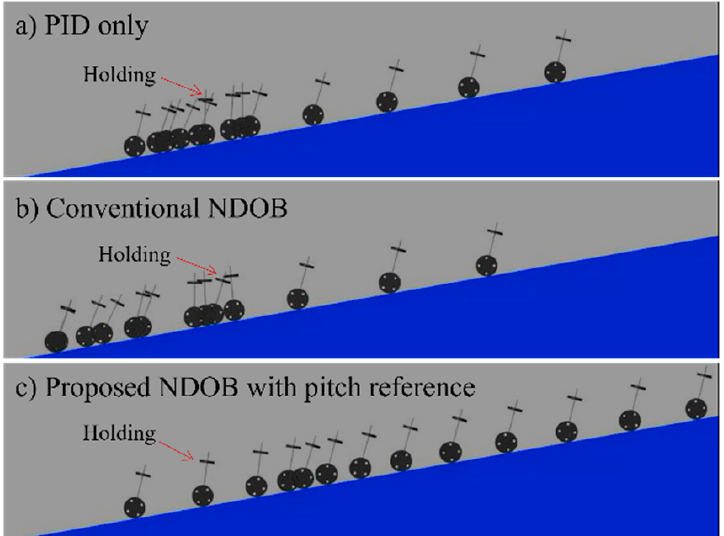
12 of 19 Figure 8. Climbing a ramp with an unknown slope of 10 degrees. The pitch references for PID and conventional NDOB were zero. Secondly, as shown in Figures 9 and 10, as the TWIP robot steadily climbed the ramp, the velocity reference changed from 1.5 m/s to 0 m/s at 10 s to hold a stationary state for 3 s. (1) When applying only the PID controller with a zero-pitch reference, it had great difficulty in making the robot stand still on a ramp. As indicated in Figure 10a, when the zero-velocity command was assigned, it tended to recover the upright posture, which resulted in a severe retreat of the TWIP owing to the gravitational moment acting on the wheels; (2) the compensation input by the conventional NDOB was not helpful at all to